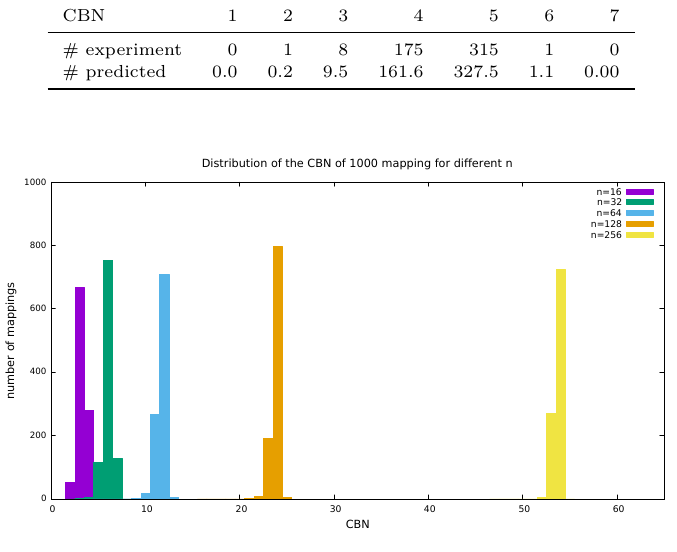
Table 3: Comparison of the CBN distribution deduced from Formula 1 with the experi- mental distribution obtained with 500 random matrices of GL(24 , F